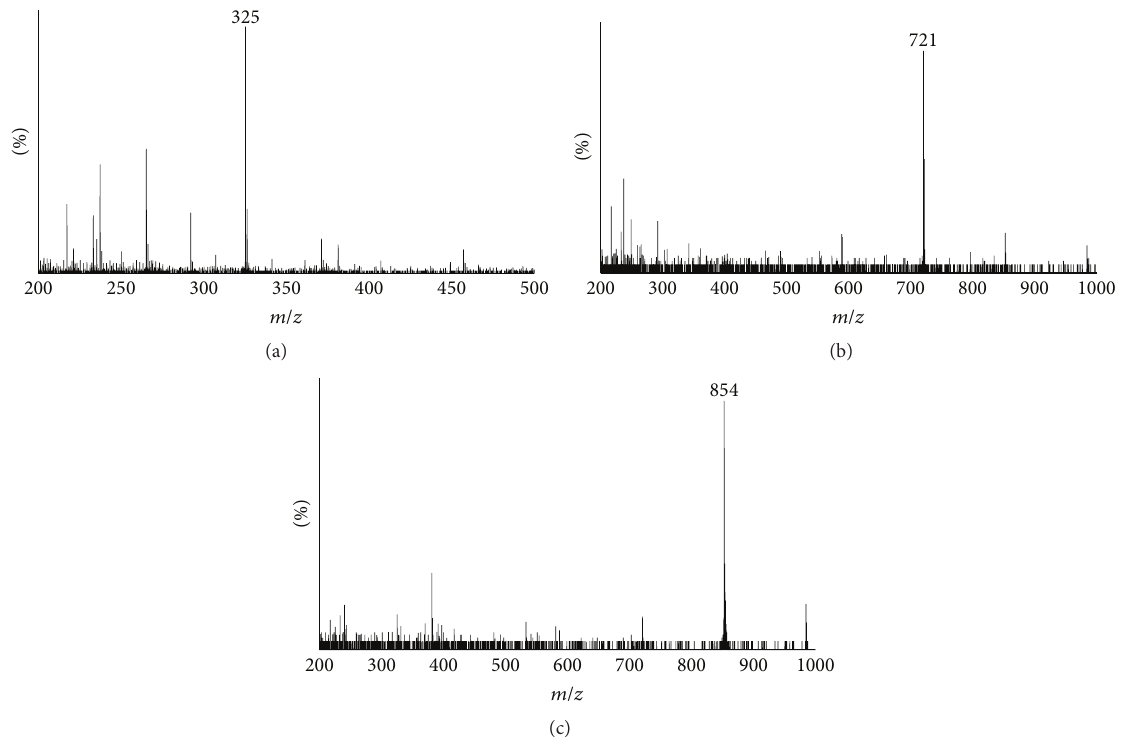
Figure 2: Negative ion mass spectra of feruloyl mono/oligosaccharide arabinoxylans [M-H] − from corn bran (a) and wheat aleurone (b and c). Compounds eluting at 26.12 and 27.57 minutes in corn bran UV spectra had the same molecular weight [M-H] − of 325 (a). Also compounds eluting at 13.28 minutes in wheat aleurone UV spectra had 𝑚/𝑧 = 721 (b) whereas those at 14.57, 15.78, 16.92, and 17.63 minutes had the same 𝑚/𝑧 = 853 (c).